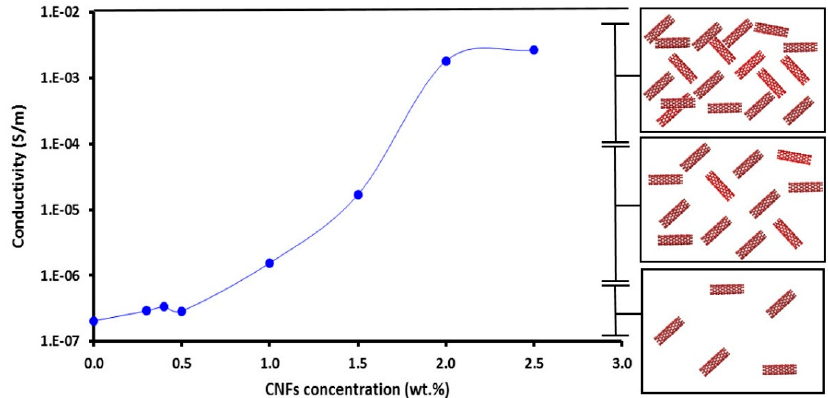
Figure 8. Change in electrical conductivity vs. weight percentage of CNFs in epoxy. The right sketch is a schematic describing the significance of altering CNFs content on the formation of the conductive network inside epoxy.